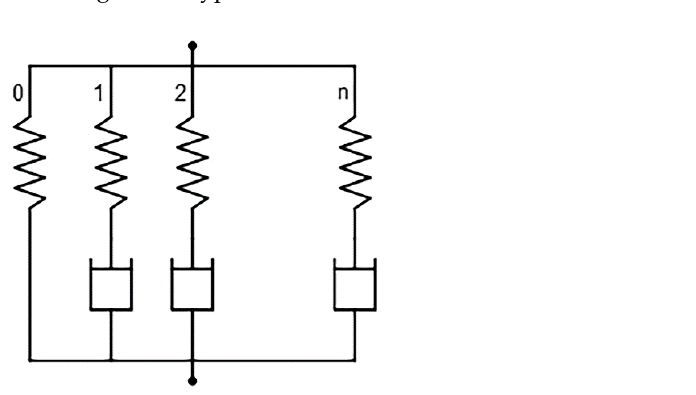
Figure 1. Model with multiple parallel hyperelastic and viscoelastic networks.